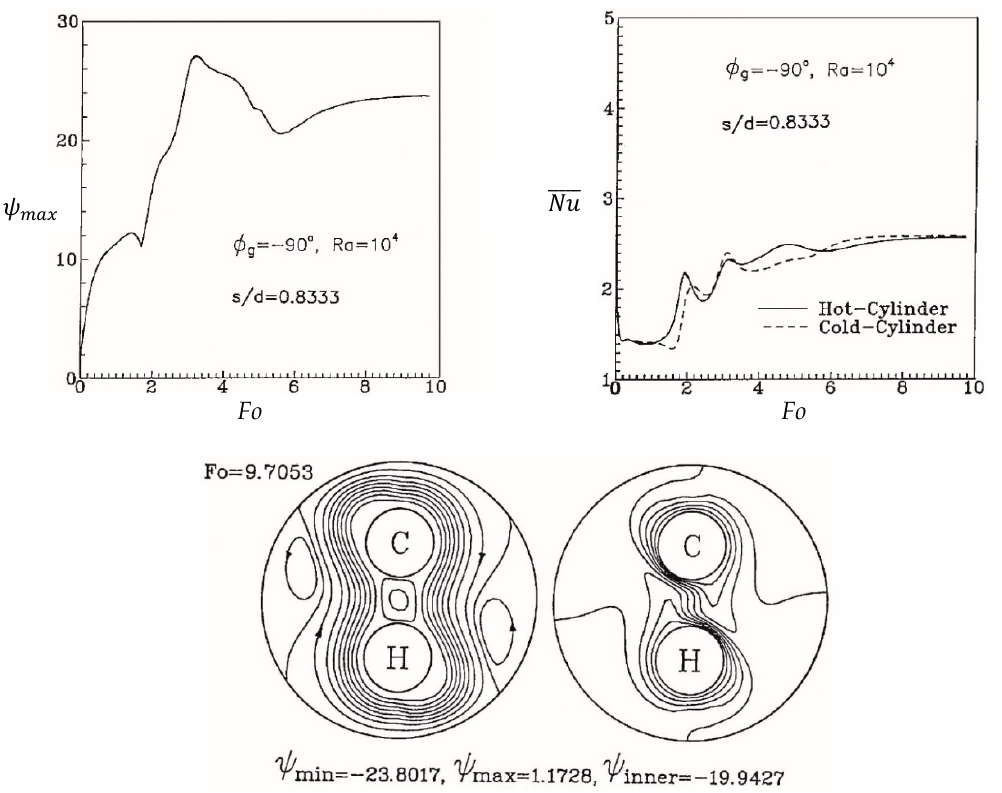
Figure 7. Variation in the maximum stream function value ( top left ) and average Nusselt number ( top right ) versus time, and the steady state flow field and temperature distribution ( bottom ) ( φ g = − 90°, Ra = 10 4 and s/d = 0.8333).